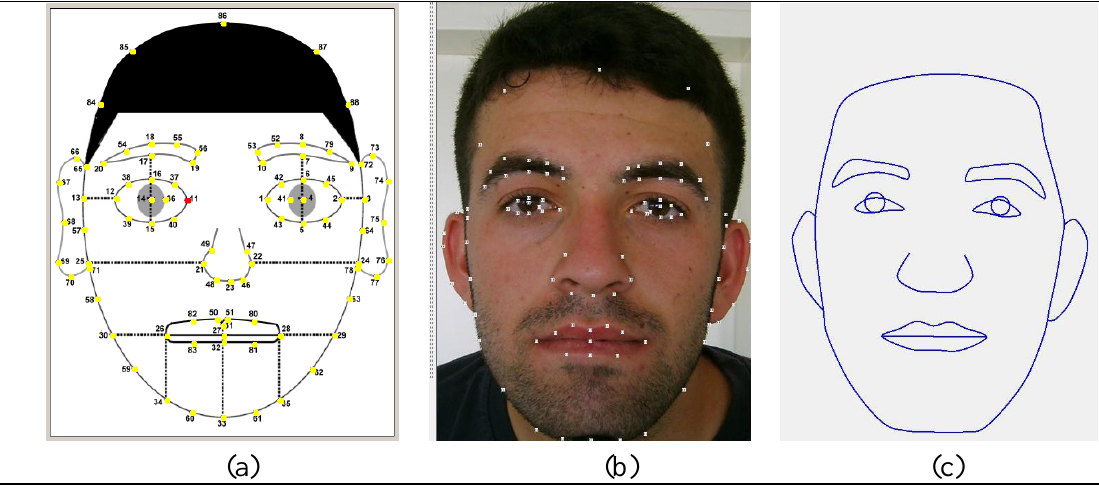
Figure 10. Face reference points a) on the template, b) on a real face image from the database, c) re-construction of the face model from the reference